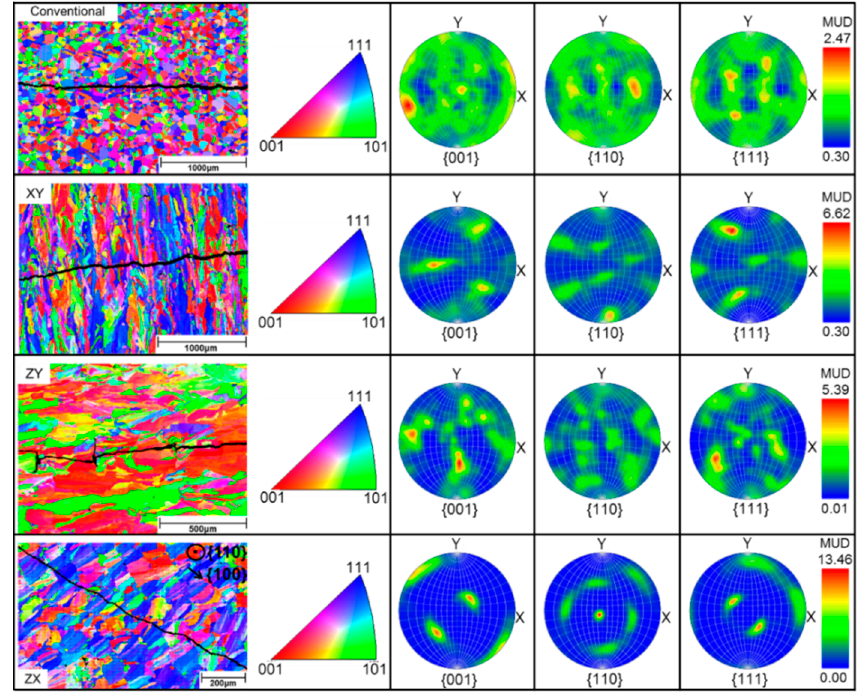
Figure 11. EBSD (electron backscatter diffraction) mappings and corresponding pole figures along fracture paths in conventional and LPBF-manufactured materials (with regard to the three different build directions).